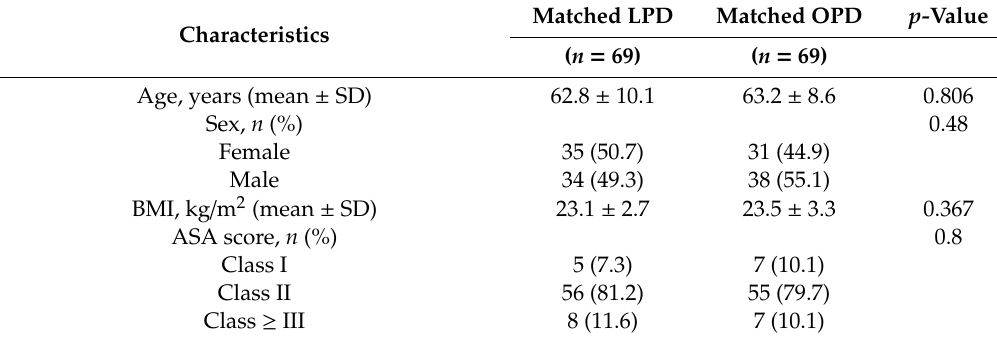
Table 4. Comparison of baseline characteristics and pathologic findings between laparoscopic pancreaticoduodenectomy (LPD) and open pancreaticoduodenectomy (OPD) groups after propensity score